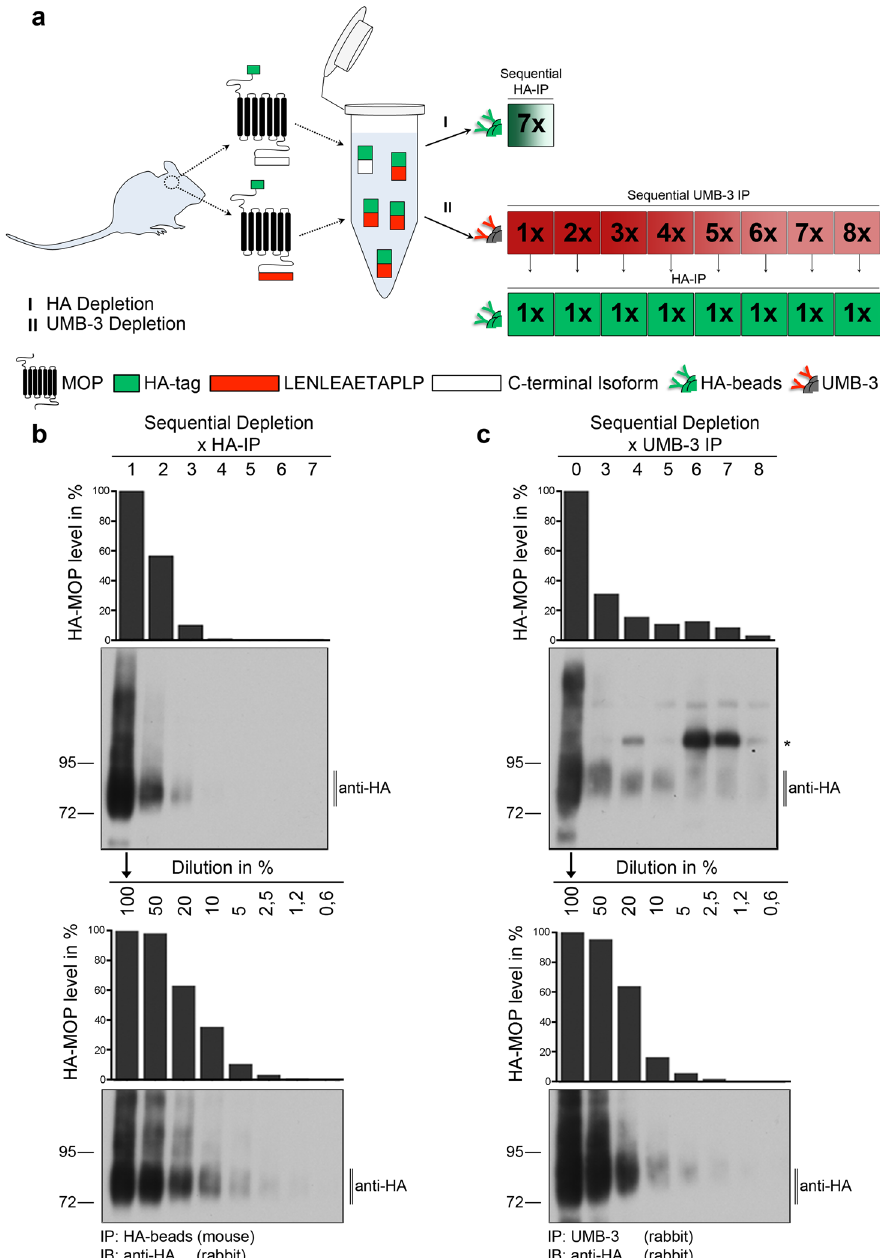
Fig. 4 Canonical HA-MOP immunodepletion experiment. a Schematic representation of the experimental procedure. b , c (Upper panel) Depletion of HA- MOP by several immunoprecipitation steps with either. b HA-tagged magnetic beads or ( c ) UMB-3-protein-A beads-conjugate. b , c (Lower panel) Dilution series of a single HA-IP sample. Results were quanti fi ed using ImageJ and Prism software. Representative results from three independent experiments are shown. The position of molecular mass markers is indicated on the left (in kDa). *Non-speci fi c antibody band in c . Blots are representative of eight independent